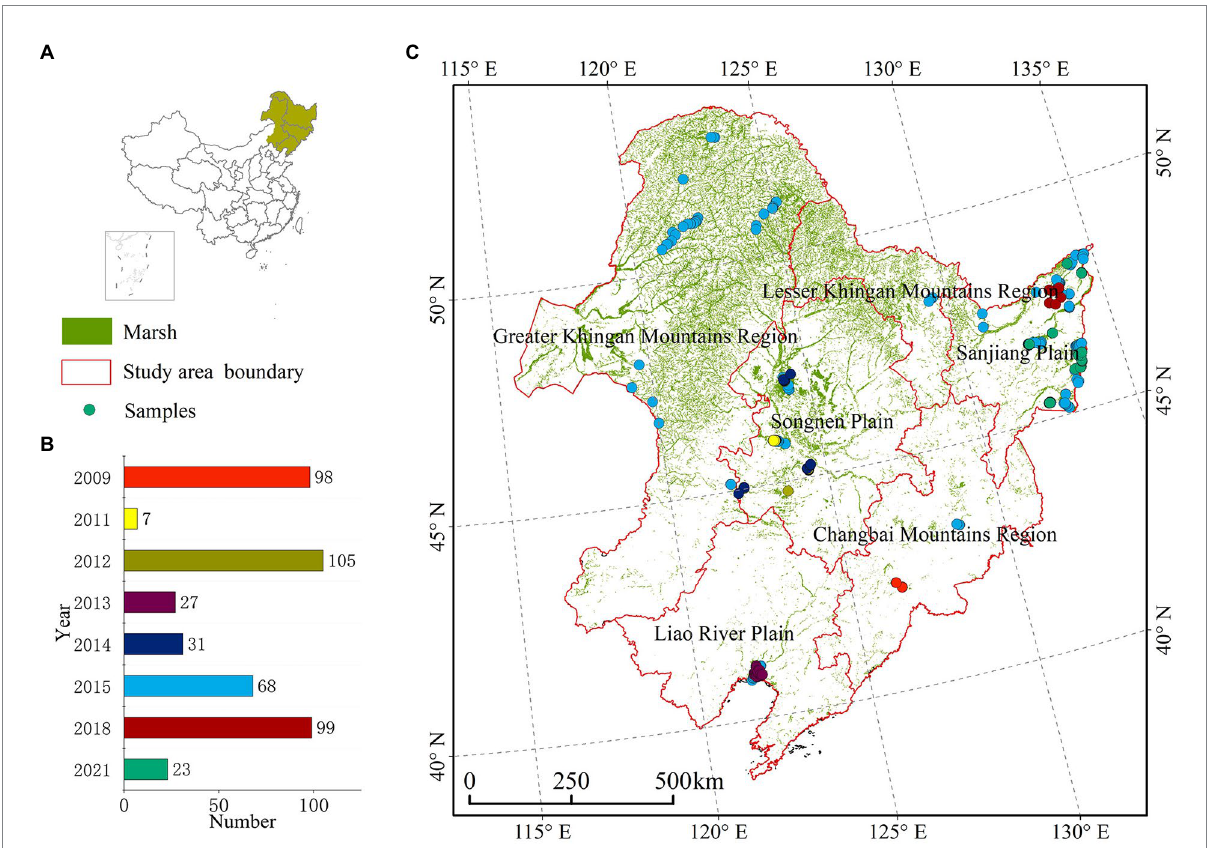
FIGURE 1 Location of Northeast China (A) , spatial distribution of marshes and filed sampling sites of aboveground biomass (AGB) in Northeast China (B) , and number of sampling sites in different years (C)